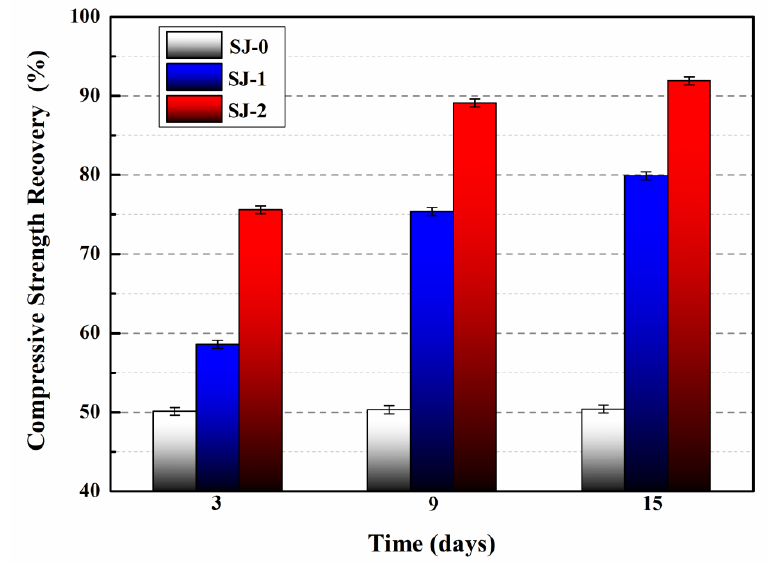
Figure 11. Compressive strength recovery of